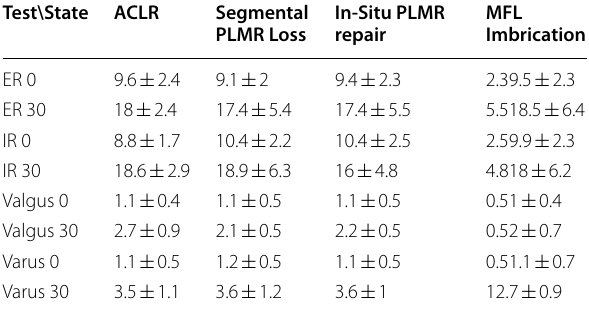
Table 3 Mean ROM (degrees) by State (columns) and Test (rows)